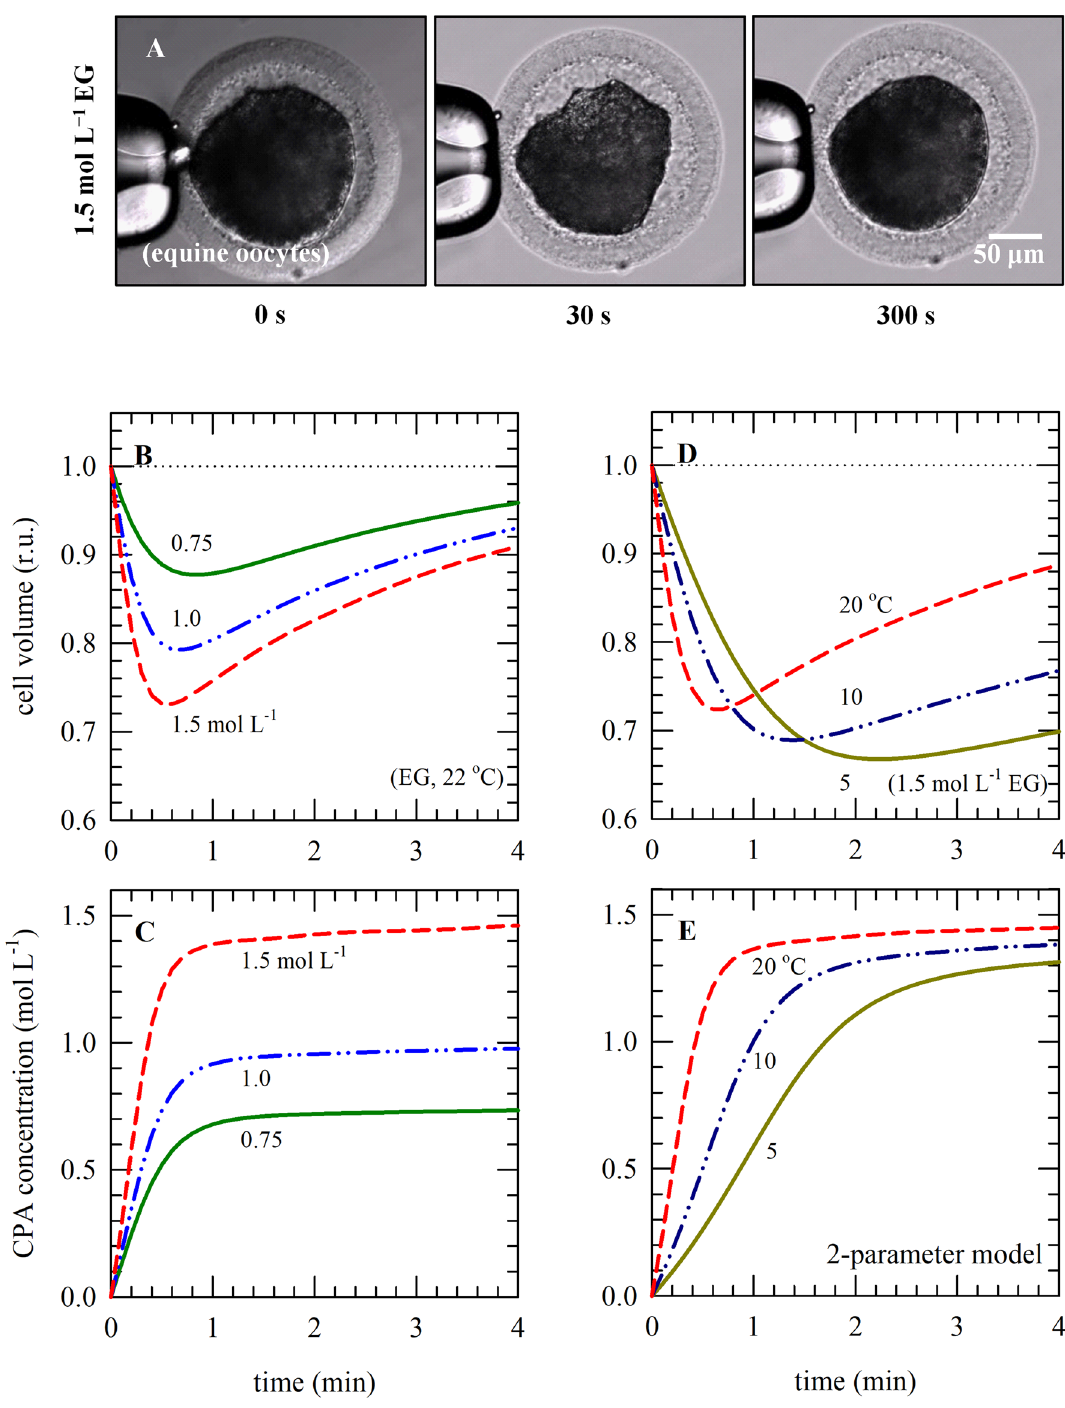
Figure 1. Oocyte volume responses and concomitant changes in the intracellular solute/CPA concentration during exposure to solutions containing different EG concentrations as well as temperatures. Simulations were done using the two-parameter transport model and MATLAB. Panel ( A ) illustrates the experimental setup used for investigating equine oocyte volume during exposure to various solutions, for deriving membrane permeability parameters used for the simulations depicted in panels ( B ‒ E ). Oocyte volume responses ( B , D ) and changes in the intracellular solute concentrations ( C , E ) were modeled during exposure to different EG concentrations at room temperature ( B , C ; 0.75 mol L −1 : green lines, 1.0 mol L −1 : blue lines, 1.5 mol L −1 : red lines) as well as temperatures in case of 1.5 mol L −1 EG ( D , E ; 20 °C: red lines, 10 °C: blue lines, 5 °C: green